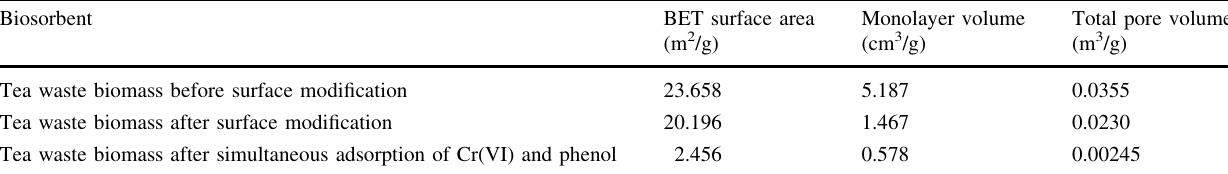
Table 4 Surface properties of tea waste biomass Biosorbent